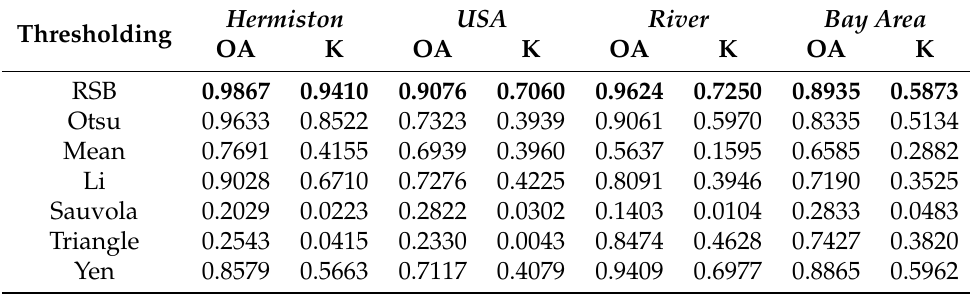
Table 1. Comparisons with other thresholding techniques. RSB achieves the best results (in bold).